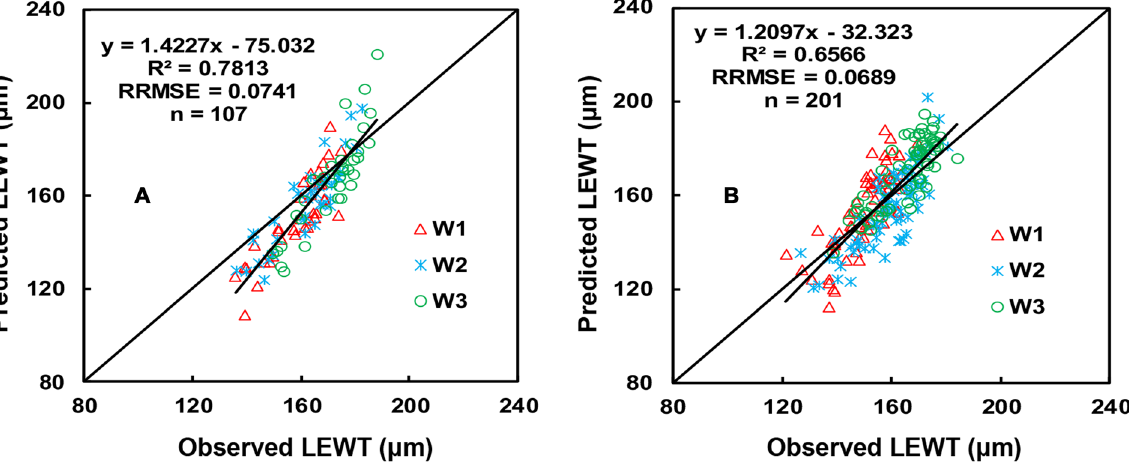
Figure 7. Quantitative relationships between NDSIe (R 1445 , R 487 ) and LEWT before anthesis (A); quantitative relationships between NDSIt (R 1714 , R 1395 ) to LEWT after anthesis (B).